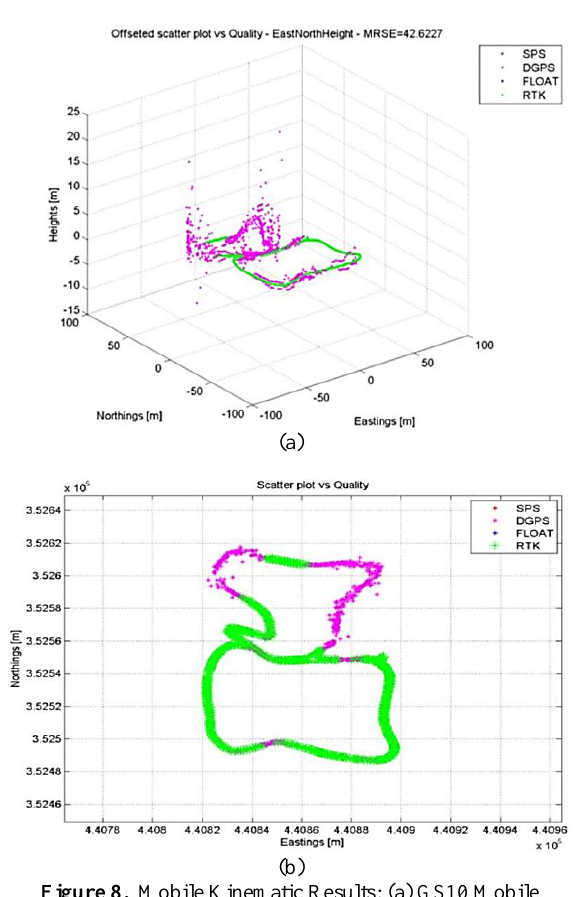
Figure 8. Mobile Kinematic Results: (a) GS10 Mobile Kinematic 3D; (b) GS10 Mobile Kinematic 2D The GS10 and Javad easting are generally of the same precision but the northing for the GS10 in marginally better than the Javad (figure 9 (a), 9 (b). 10 (a) and 10 (b)). When figure 11 (a) and 11 (b) are compared the Javad had the better HDOP in some part of the open areas of the